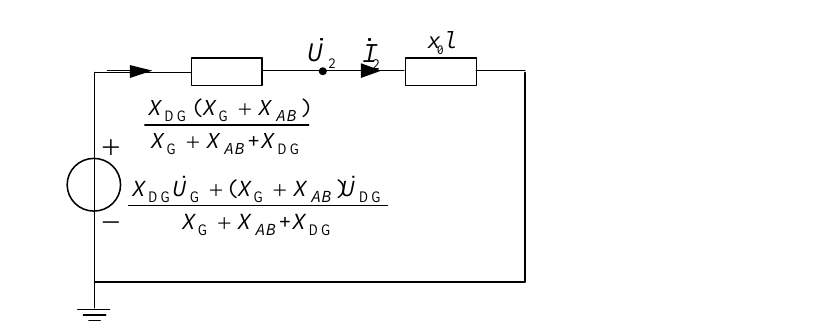
Figure 3. Diagram of distribution network with DG.